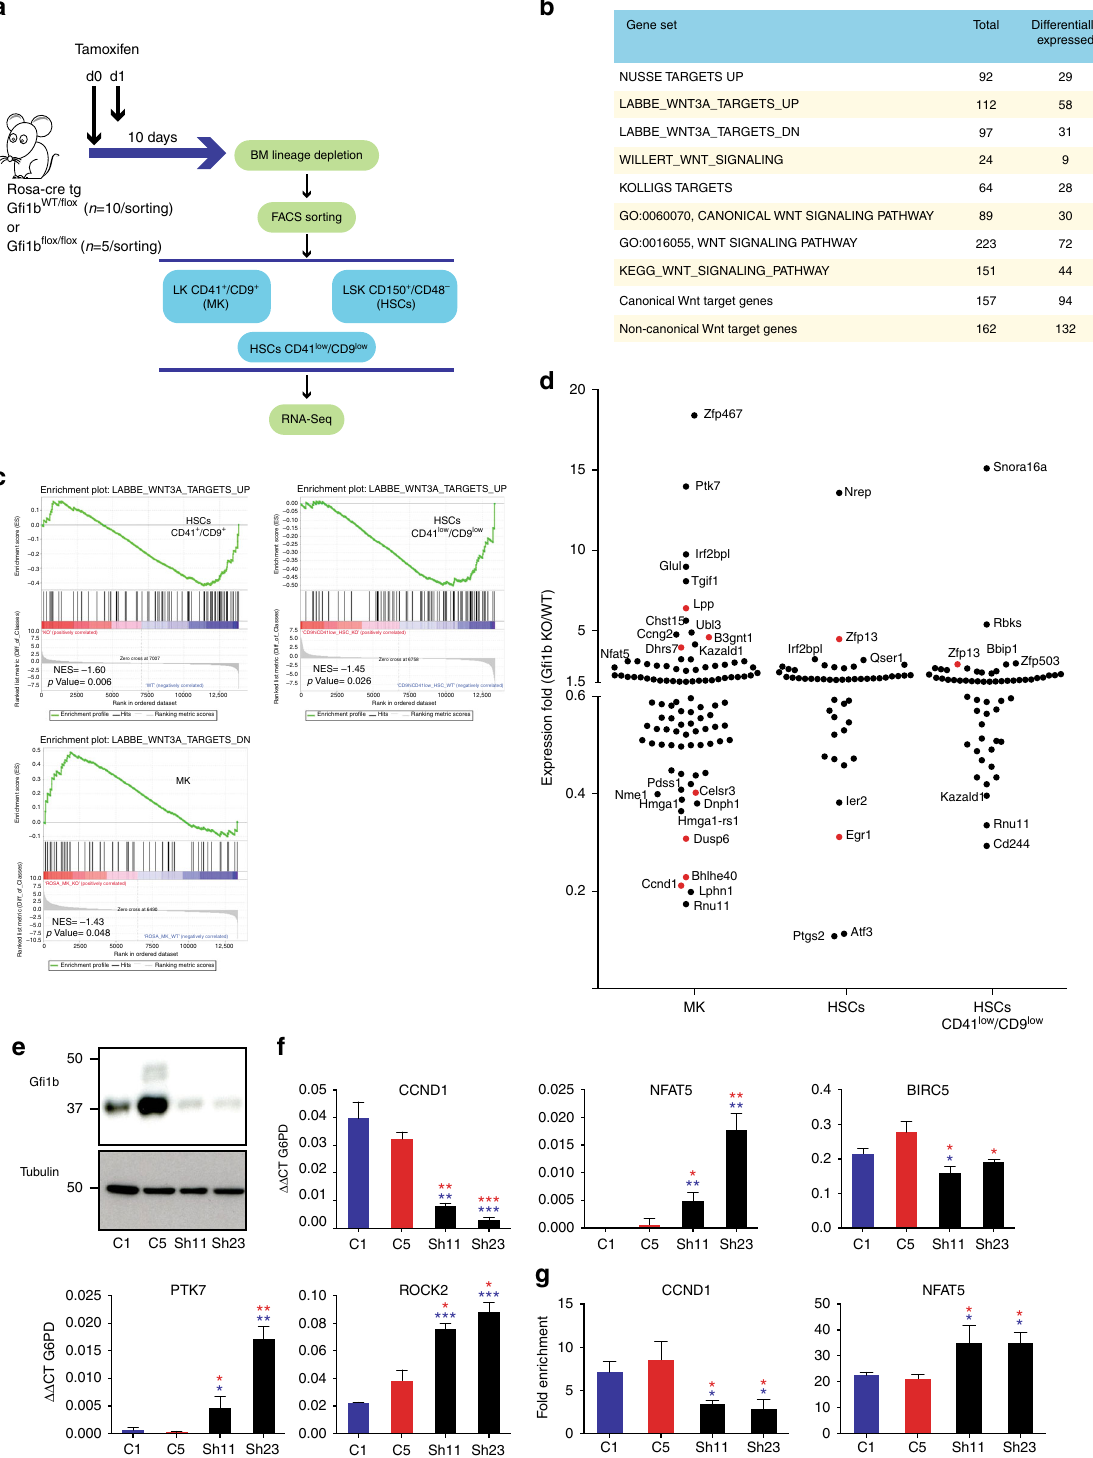
Fig. 6 Deregulation of Wnt/ β -catenin target gene expression in G fi 1b-de fi cient MKs and HSCs. a Gene expression analysis was done on sorted G fi 1b WT/ KO MKs, HSCs and HSCs CD41 low /CD9 low as indicated. b , c Gene set enrichment analysis (GSEA) of RNA-seq data from the sorted cells using published Wnt related gene sets (see Supplementary Table 2 for gene set references). d RNA-seq expression analysis of G fi 1b/ β -catenin co-occupied genes (based on published ChIP-seq data) in the three G fi 1b WT/KO populations. Genes indicated in red also have peaks for LSD1 at their promoter. e GFI1B expression in two independent K562-derived cell lines stably expressing a scrambled control shRNA (C1, C5) and two lines expressing a GFI1B speci fi c shRNA (Sh11, Sh23). f Expression analysis of Wnt target genes by RT-PCR in GFI1B shRNA KD and scramble shRNA stable K562 clones. g Enrichment of acetylated H3K9 at GFI1B/ β -catenin target gene promoters by ChIP-qPCR in GFI1B shRNA KD and scramble shRNA stable K562 clones. (* P < 0.05, ** P < 0.001, *** P < 0.0001 on a Welch corrected t -test compared to C1 (in blue) or C5 (in red), error bars show s.d, n = 3 technical